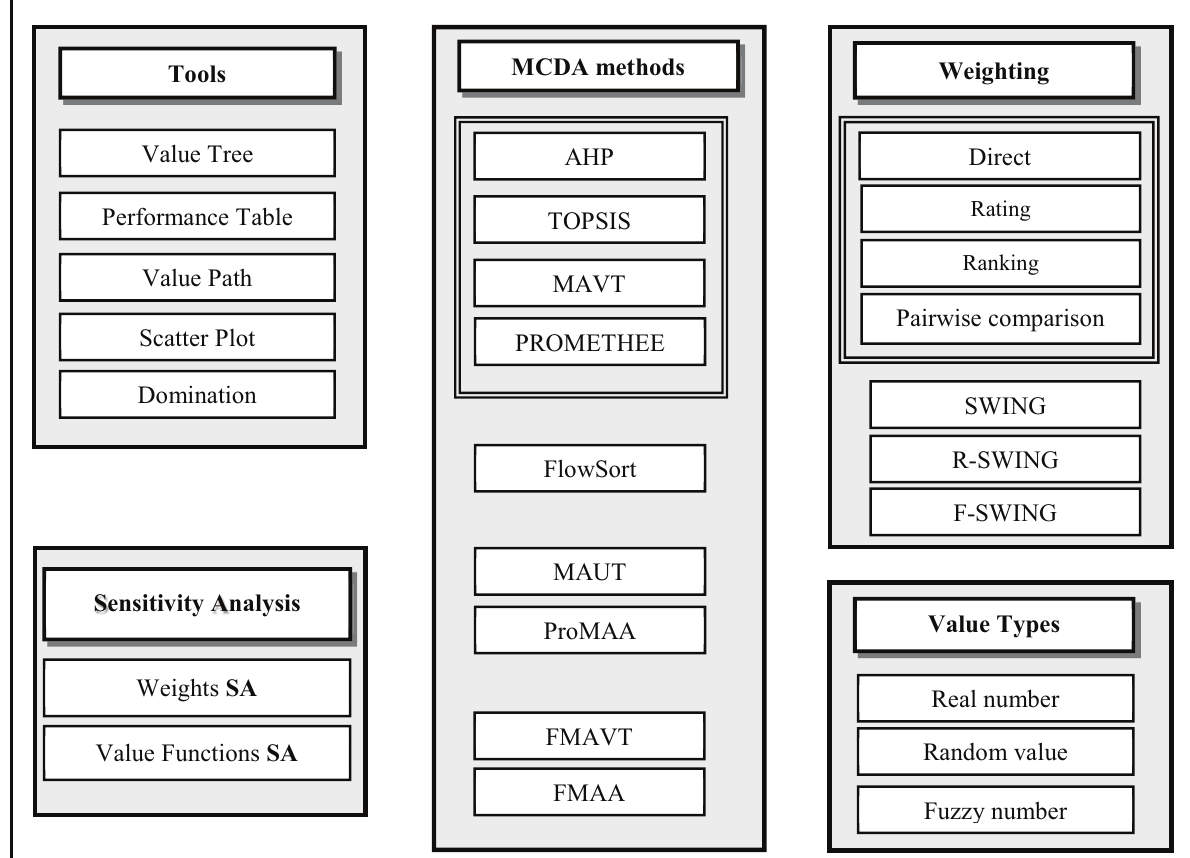
Fig.3. A general scheme of the DecernsMCDA